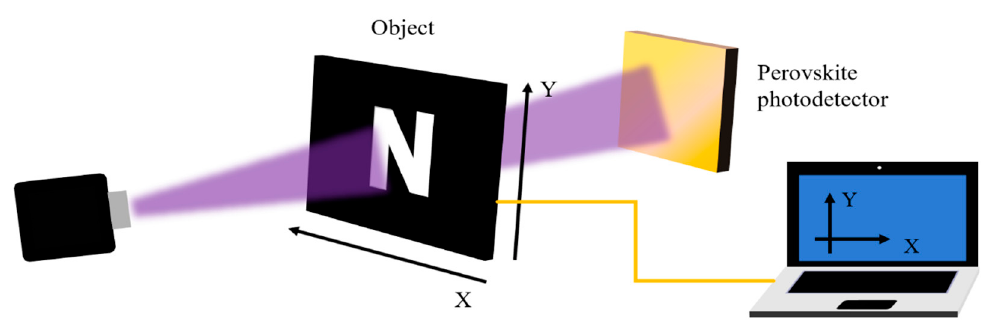
Figure 7. Schematic diagram of the imaging system.